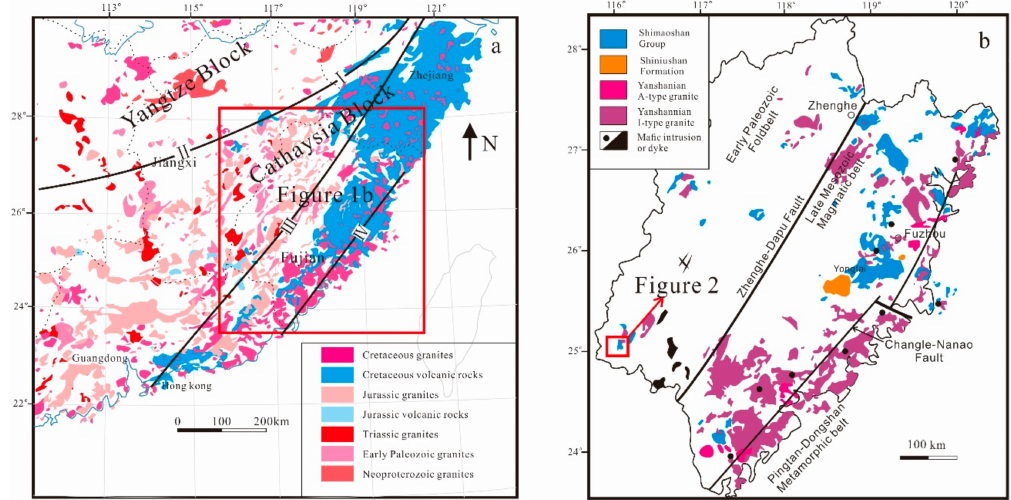
Figure 1. ( a ) Schematic geological map of South China showing the distribution of Mesozoic granitoids and volcanic rocks, modified from [10]. I—Jiangshan-Shaoxing Fault; II—Pingxiang-Yushan Fault; III—Zhenghe-Dapu Fault; IV—Changle-Nanao Fault. ( b ) Geological map depicting the distribution of Cretaceous magmatism in Fujian Province, modified from